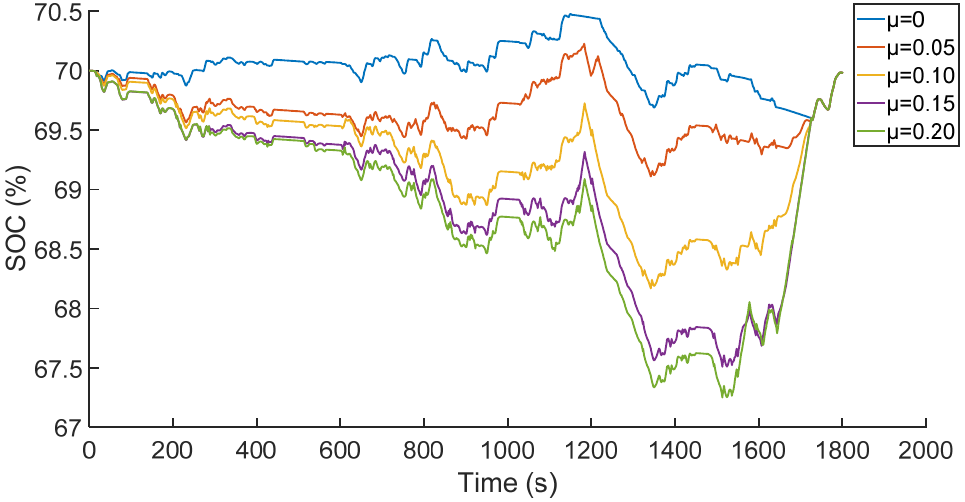
Figure 14. The variation curves of SOC pertaining to different 𝜇 for emission particle.